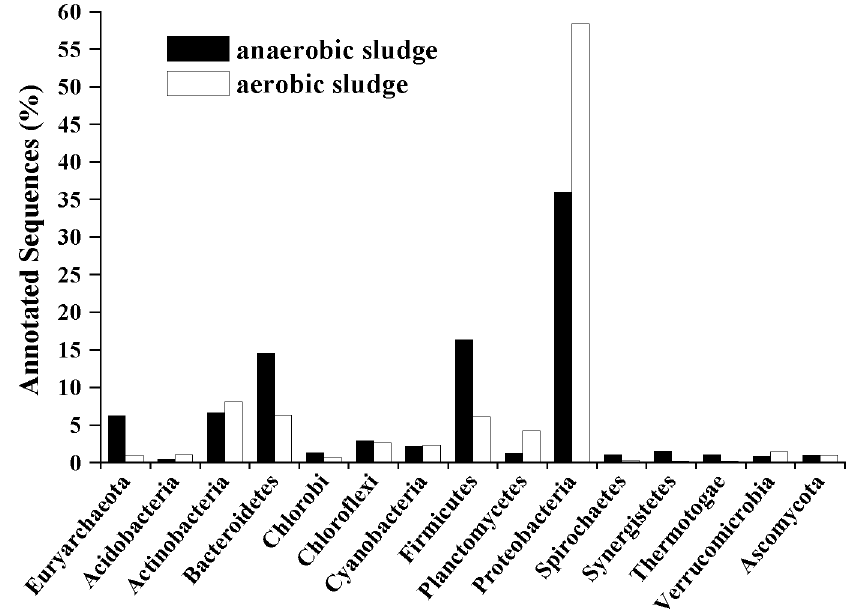
Figure 1. Combined taxonomic phylum information of anaerobic and aerobic sludge. The phyla shown have relative abundance over 1% of total sequencing reads annotated at phylum level in either anaerobic or aerobic sludge. doi: